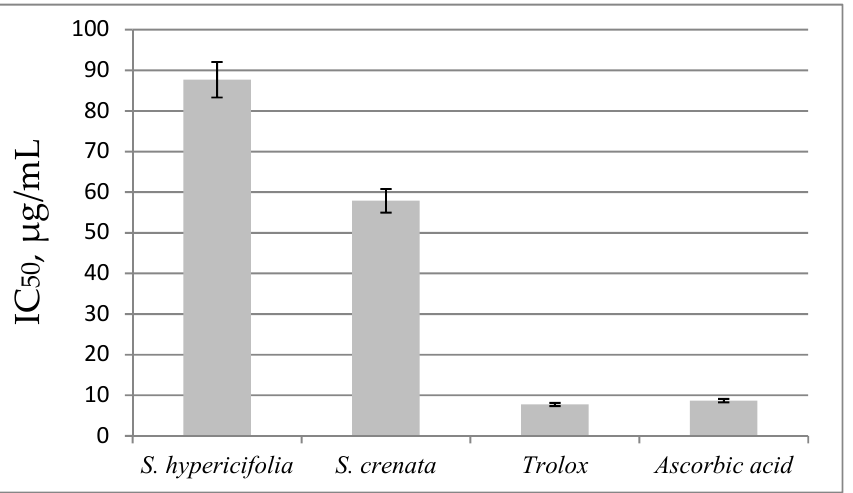
Figure 1. DPPH radical–scavenging activity of the two extracts. IC 50 , µg/mL of dry extract: concen- tration of an antioxidant at which 50% inhibition of the DPPH radical is observed.